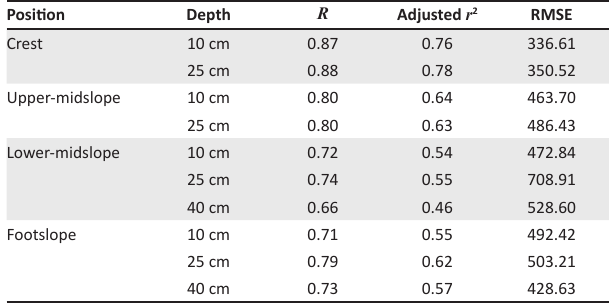
TABLE 5: Correlations between measured and simulated matric potentials (kPa) of different soil horizons along the